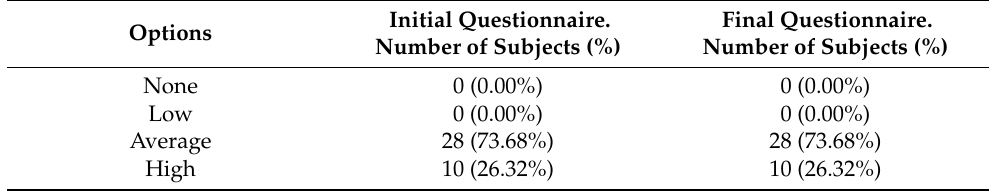
Table 4. Item 2: Efficiency of this new method.